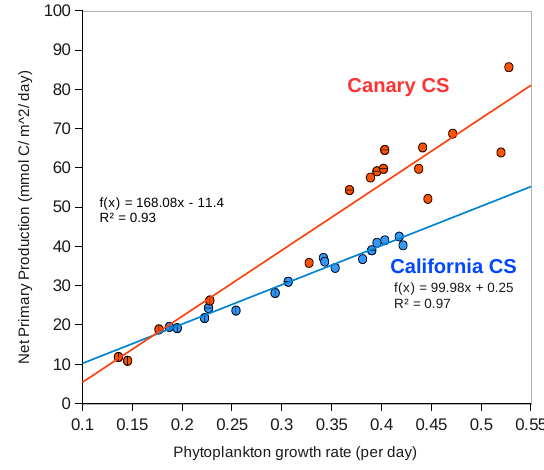
Fig. 7. The relationship between NPP and the phytoplankton growth rate in the California CS (blue) and Canary CS (orange). Data were averaged over the 300km wide nearshore area and over 1 ◦ bins in meridional direction. Circles with horizontal lines corre- spond to the southernmost part of each system, i.e., from 30 ◦ N to 34 ◦ N for the California CS and from 12 ◦ N to 16 ◦ N for the Canary CS, and circles with vertical lines indicate their northernmost parts, i.e., from 42 ◦ N to 46 ◦ N for the California CS and from 24 ◦ N to 28 ◦ N for the Canary